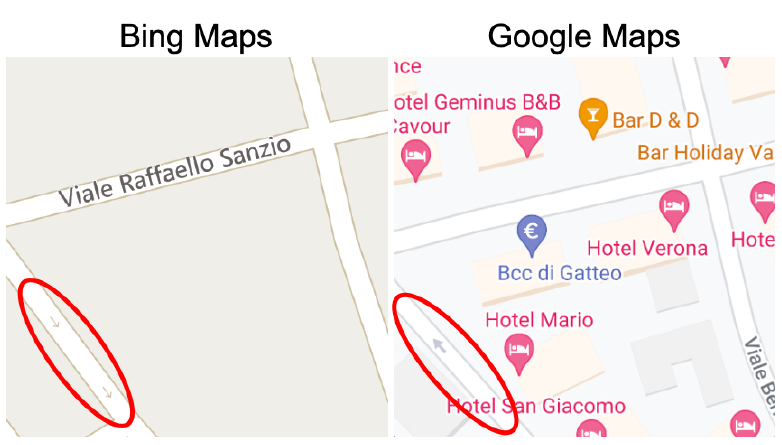
Figure 21. Type 2 (strong discrepancy) example #3-Italy.